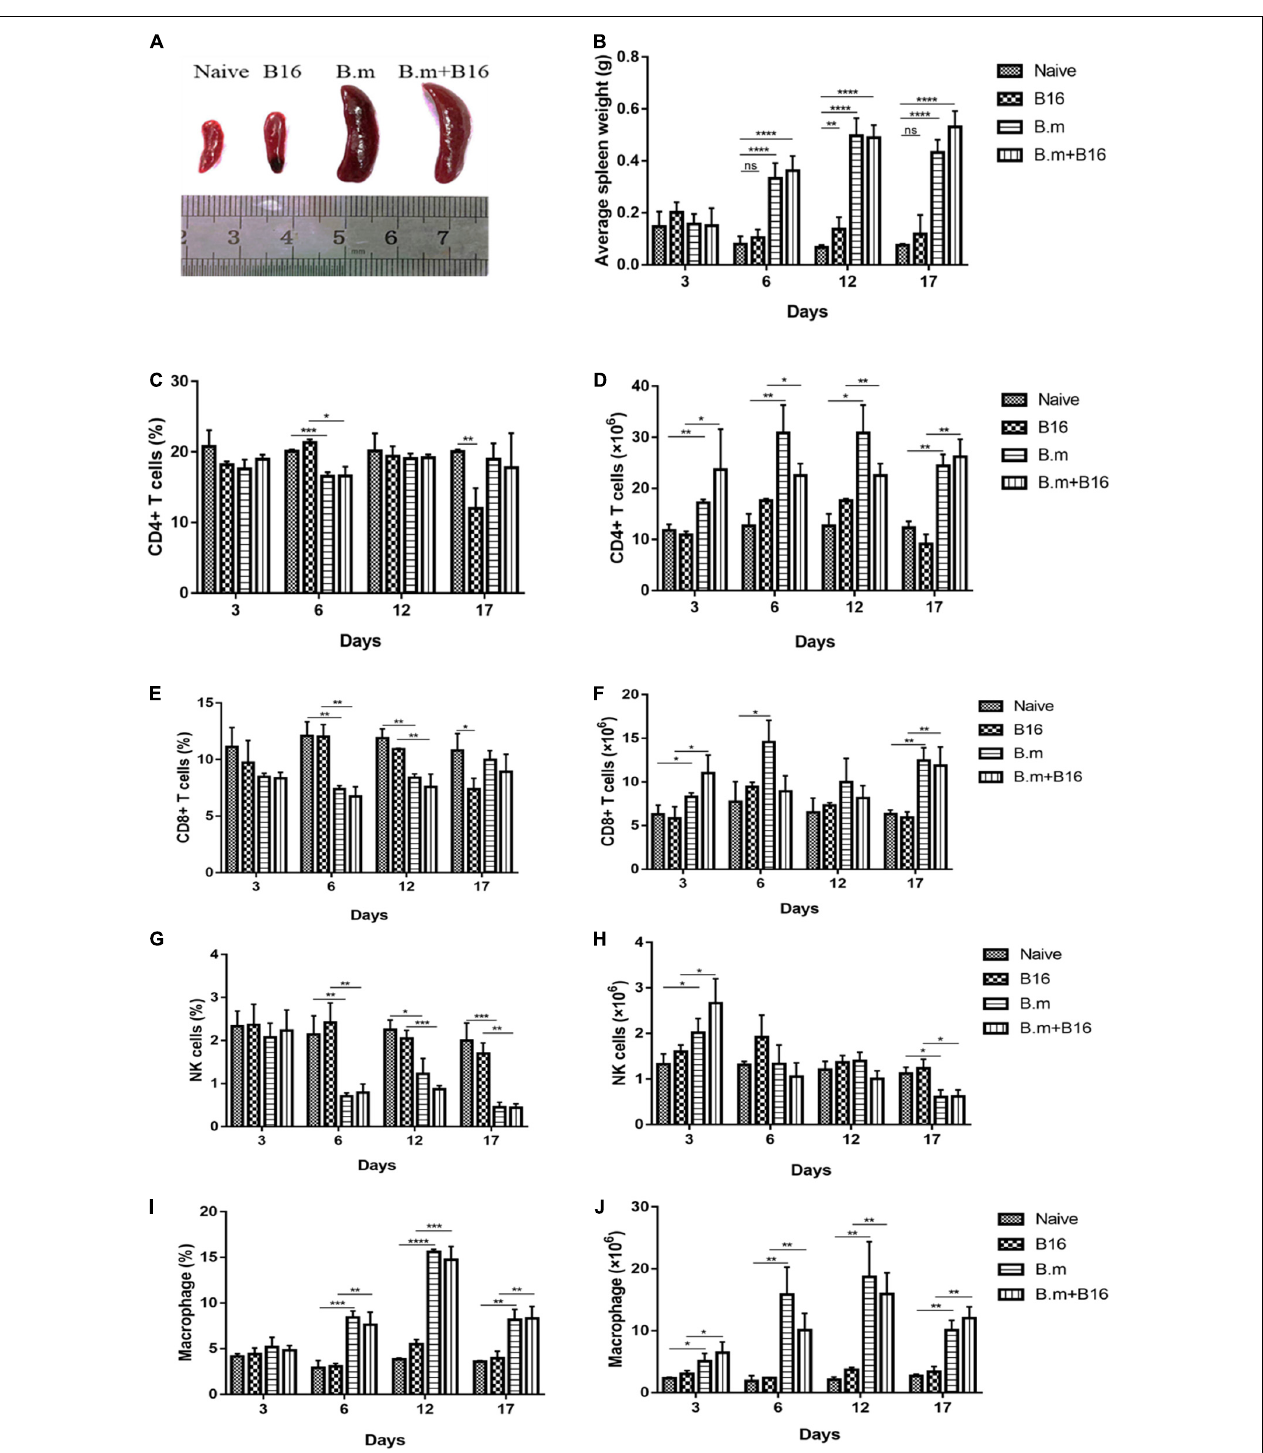
FIGURE 2 | Effects of B. microti infection on spleen morphology and splenocytes in mice. (A) Images of spleens in the four groups, with the spleen size being significantly increased in B. microti -infected mice vs. uninfected mice. (B) Changes of spleen weight of mice from day 3 to 17 post-tumor cell injection, with the weight of the spleen being significantly increased in the infection process. (C,D) Proportion and number of CD4+ T cells in the spleen of each group from day 3 to 17 post-tumor cell injection. (E,F) Proportion and number of CD8+ T cells in the spleen of each group from day 3 to 17 post-tumor cell injection. (G,H) Proportion and number of NK cells in the spleen of each group from day 3 to 17 post-tumor cell injection. (I,J) Proportion and number of macrophages in the spleen of each group from day 3 to 17 post-tumor cell injection. Error bars are SD; * p ≤ 0.0332, ** p ≤ 0.0021, *** p ≤ 0.0002, **** p ≤ 0.0001, ns: no significance. There were 5 mice in each